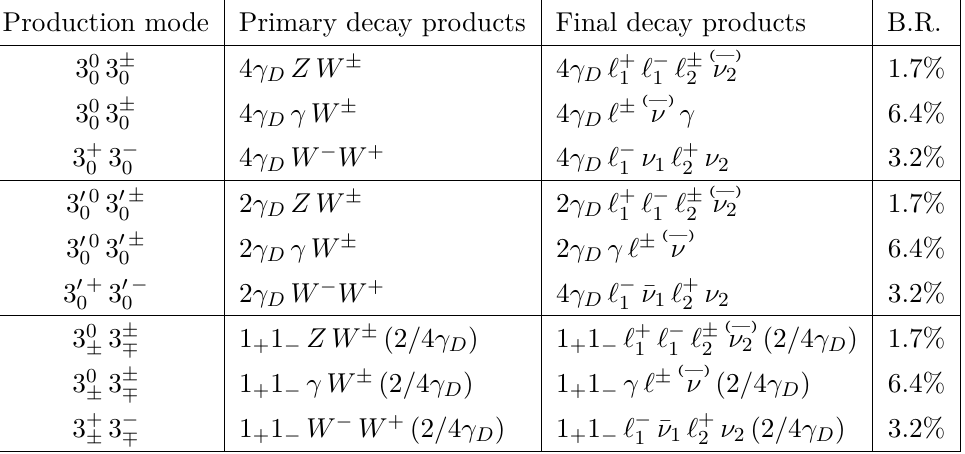
Table 5 . Branching ratios into leptonic final states for each pair of triplets produced via Drell- Yan processes, assuming a normal hierarchy. Upper (lower) indices indicate the electromagnetic ( U(1) 3 V ) charge of each particle. Leptons appearing in the third column can belong to any of the three SM families, while the values in the fourth column report the branching ratios into fully leptonic final states and include the branching ratio of taus into lighter leptons. is schematically modelled